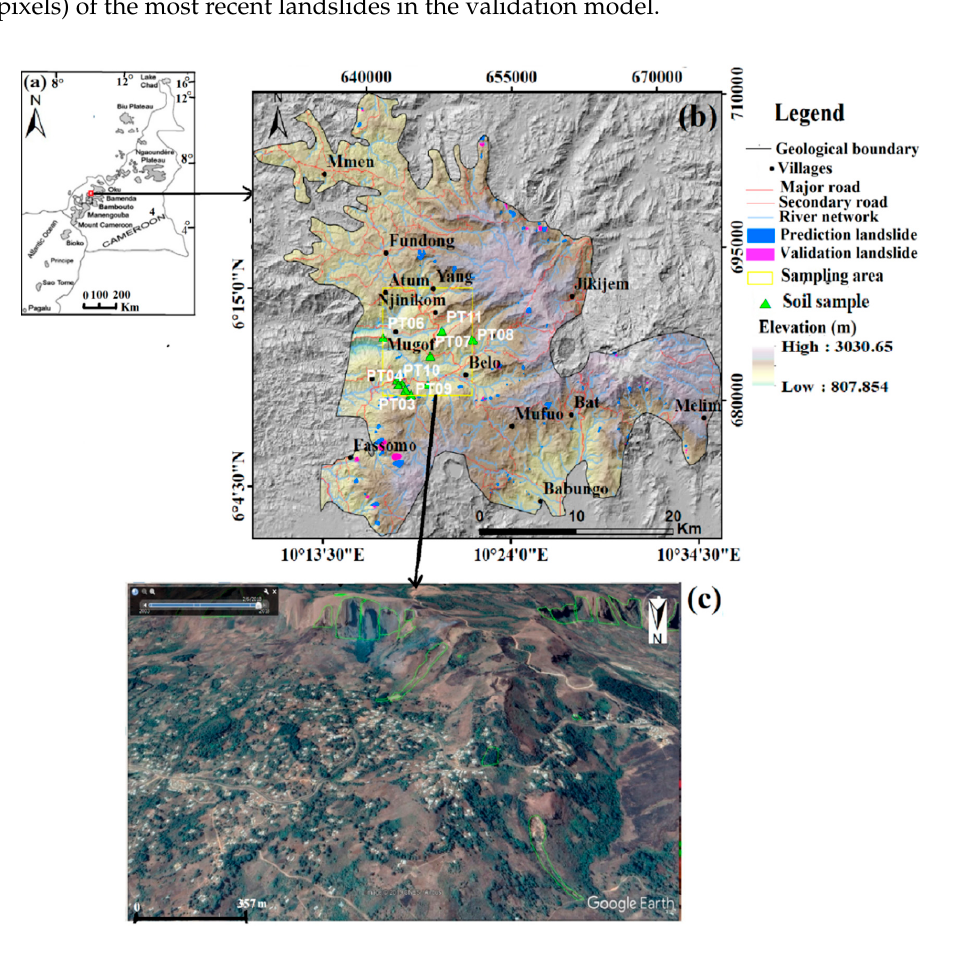
Figure 3. ( a ) Mount Oku location on the Cameroon Volcanic Line. The study area situated on the central part is symbolized by the red square (modified from [42]); ( b ) an enlargement of this area with the 12-m TANDEM X-derived elevation as base map, showing landslides (yellow rectangle); ( c ) Google Earth image showing landslides (green polygons) observed between 2009–2018.